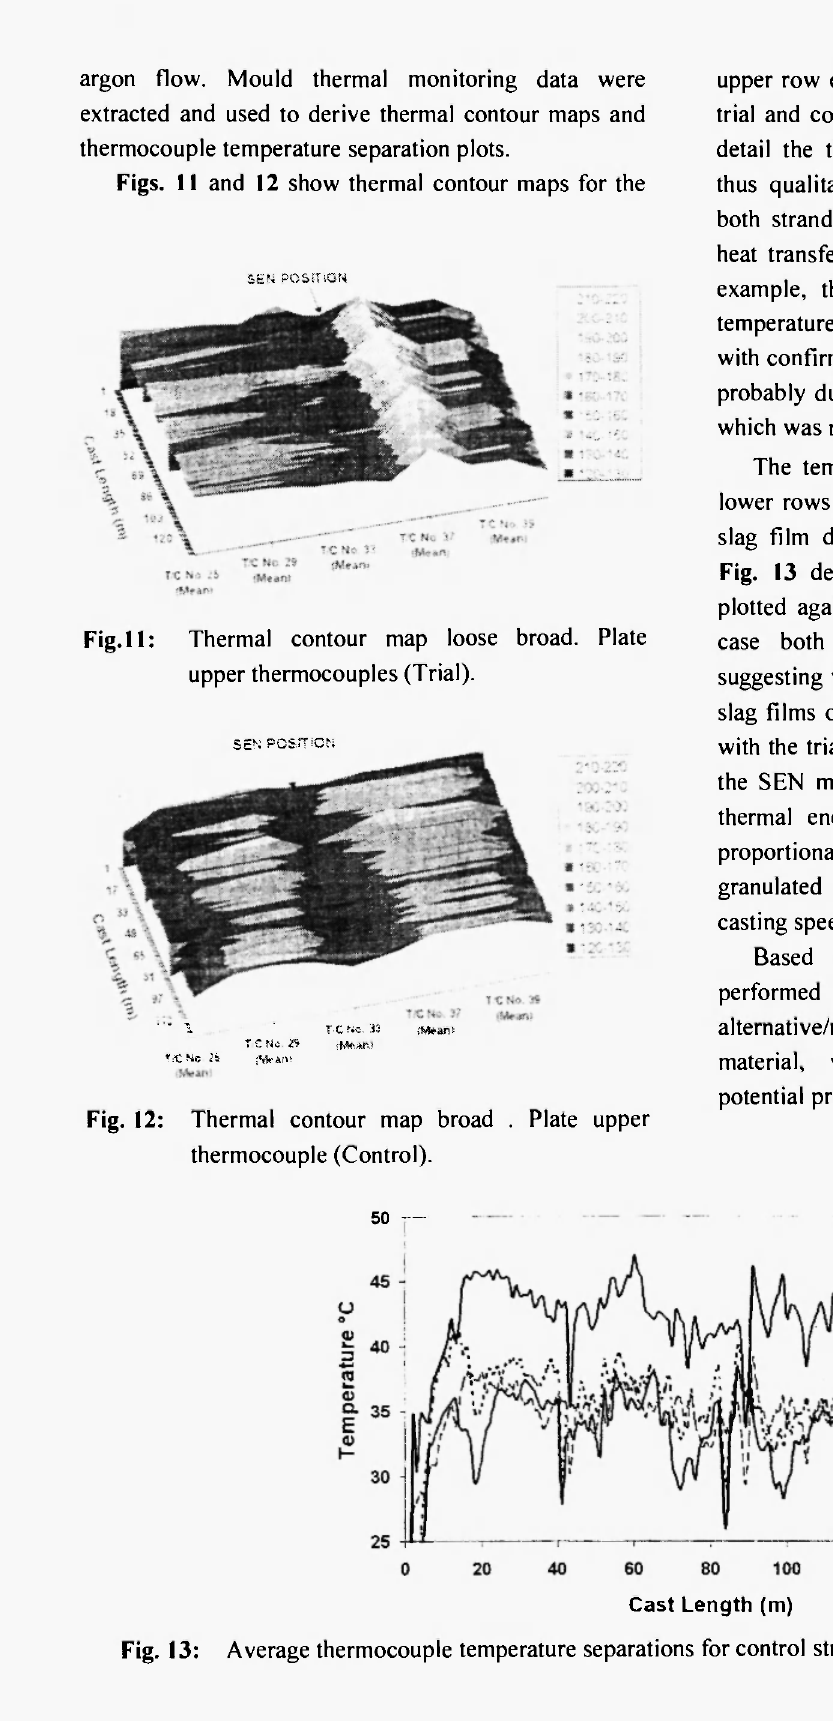
Fig. 13: Average thermocouple temperature separations for control strand (Strand 5) and trial strand (Strand 6).